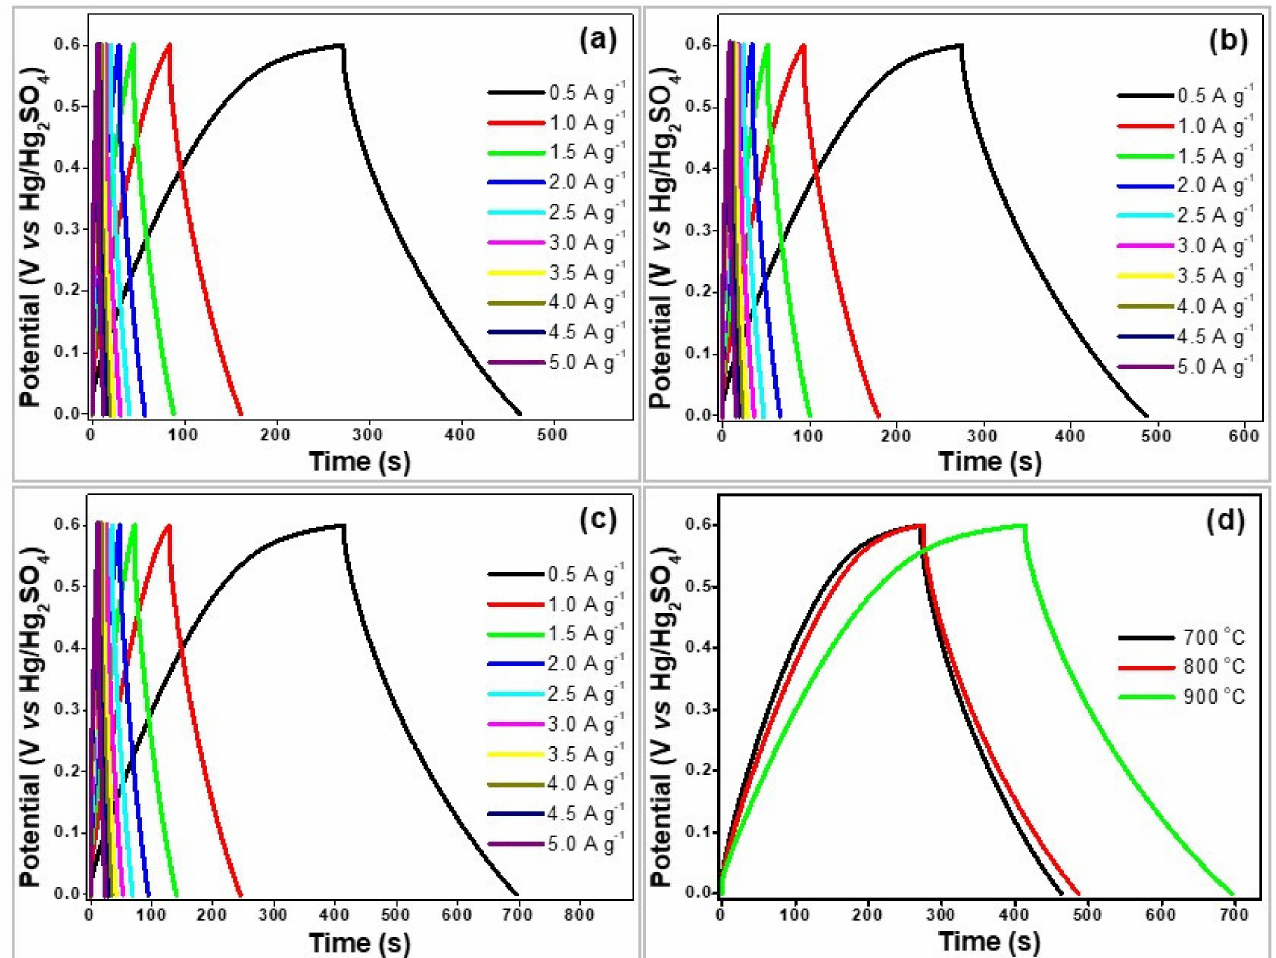
Figure 7. GCD curves of NRPCs at different current densities ( a ) NRPC-700, ( b ) NRPC-800, ( c ) NRPC-900 and ( d ) GCD curves of NRPCs at a current density of 0.5 A g − 1